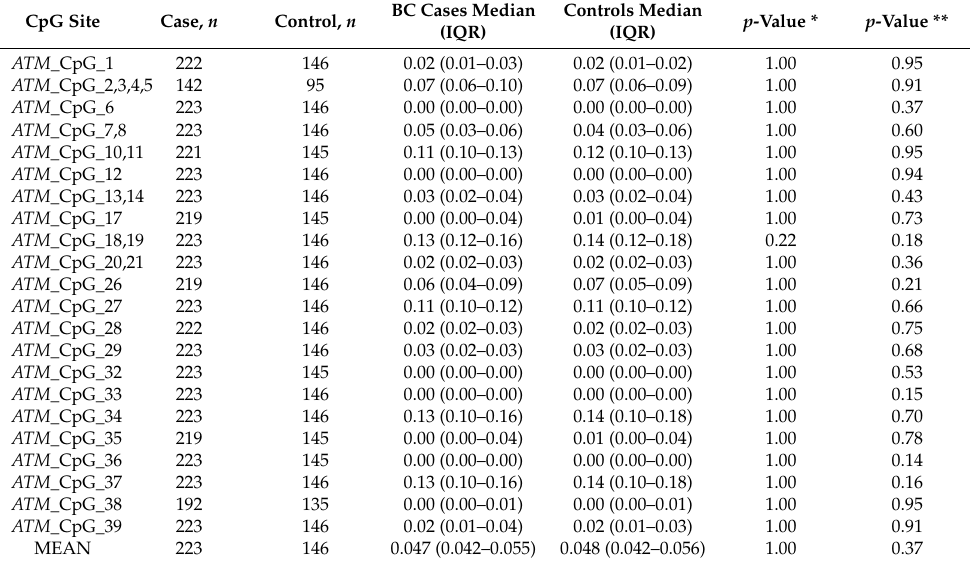
Table 2. Comparison of ATM DNA methylation between the BC patients and the healthy controls in peripheral